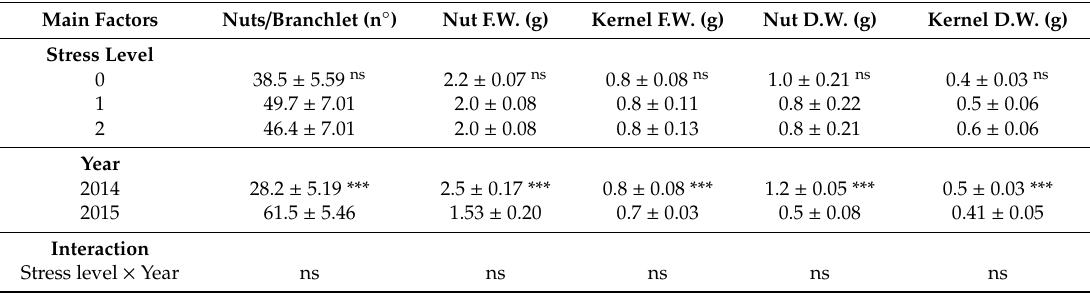
Table 1. E ff ect of water stress levels and the year on the following biometric parameters: numbers of fruits per branchlet (n ◦ ), fresh weight (F.W., g) and dry weight (D.W., g) of nuts and kernels.